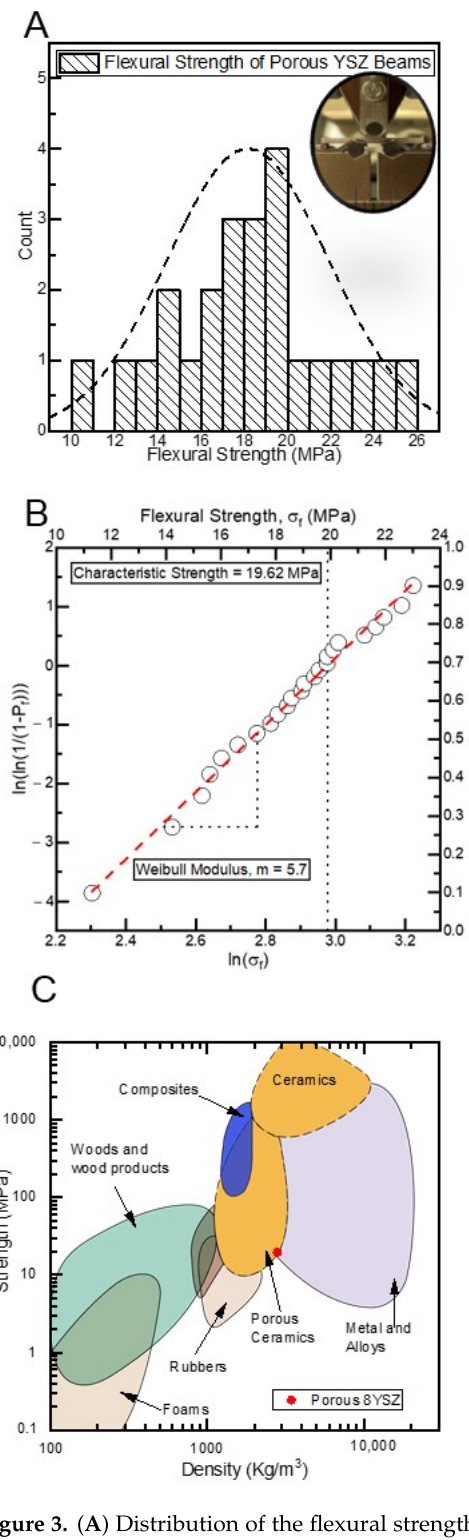
Figure 3. ( A ) Distribution of the flexural strength of porous YSZ beams. ( B ) The Weibull analysis and characteristic strength of porous YSZ beams ( n = 24). ( C ) An Ashby plot of flexural strength vs. density, in which the red dot denotes the porous YSZ in this work.